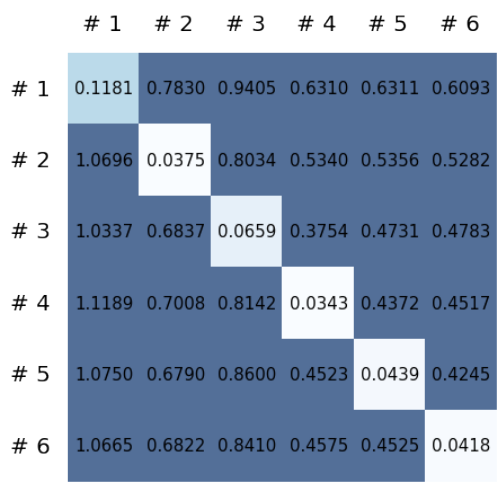
Figure 17. MSE values of the FNO model using CRP for each subject for walking motion.